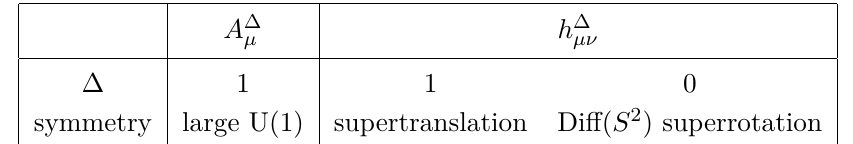
Table 1 . Conformal Goldstone modes for bosonic particles with spin s ≤ 2